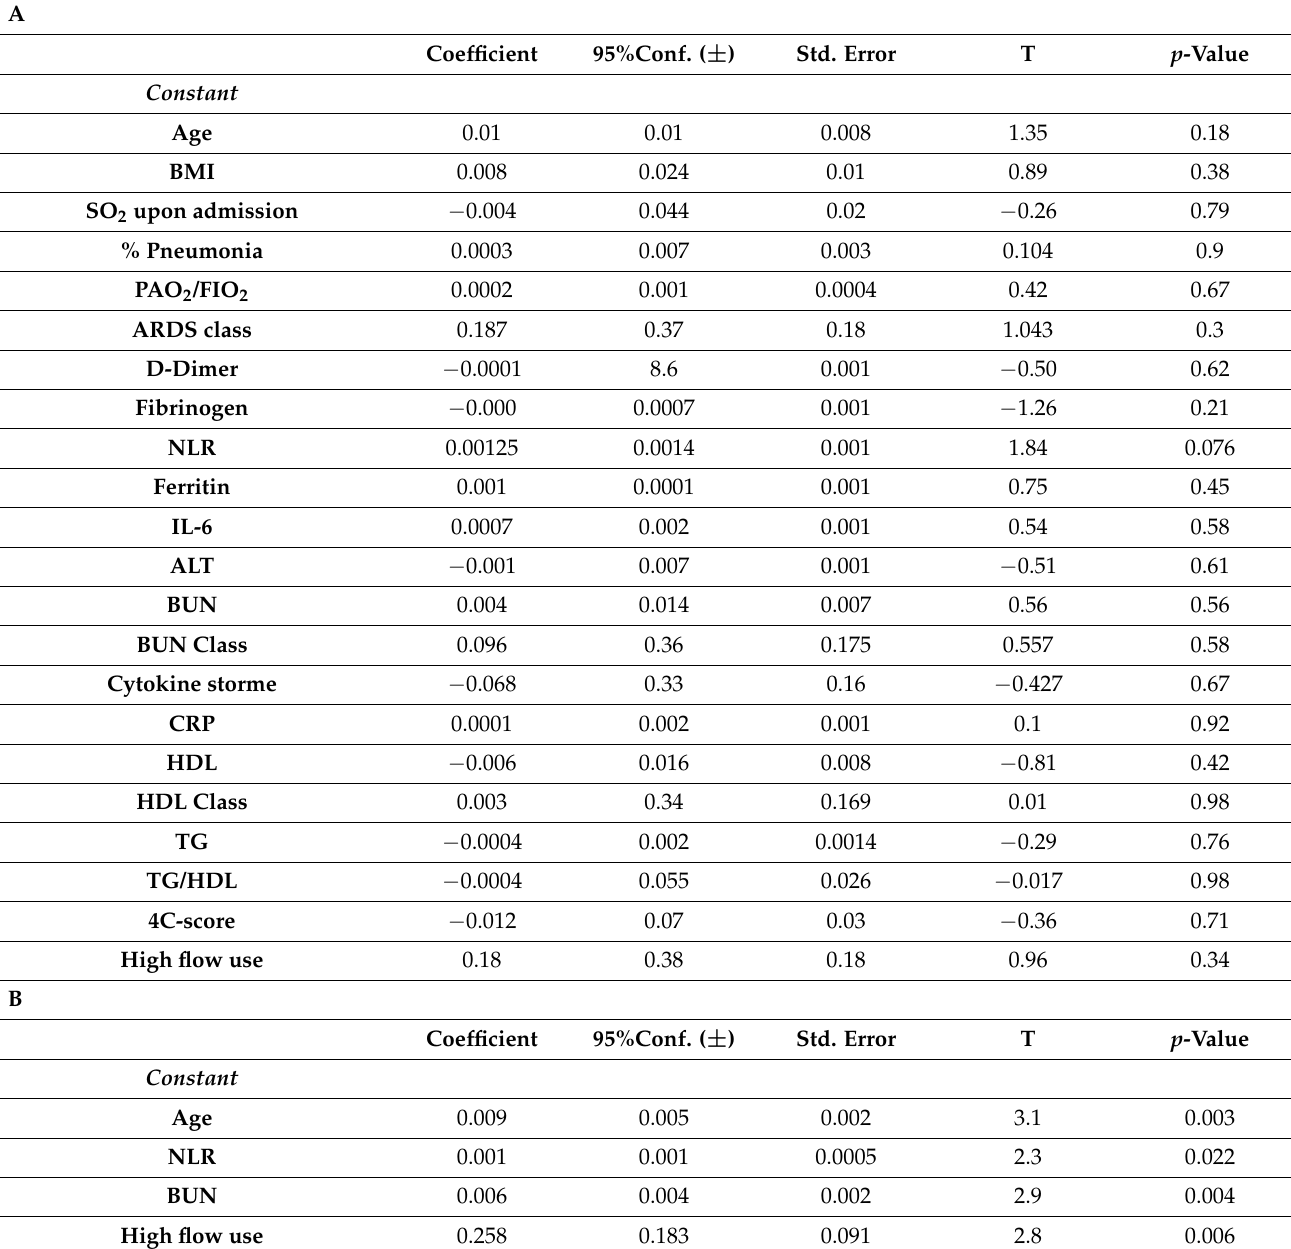
Table 3. ( A ): Univariate analyses of the strength of clinical and laboratory tests in predicting mortality in COVID-19 patients. ( B ): Multiregression analyses of the clinical parameters, blood tests and their correlation to mortality in COVID-19